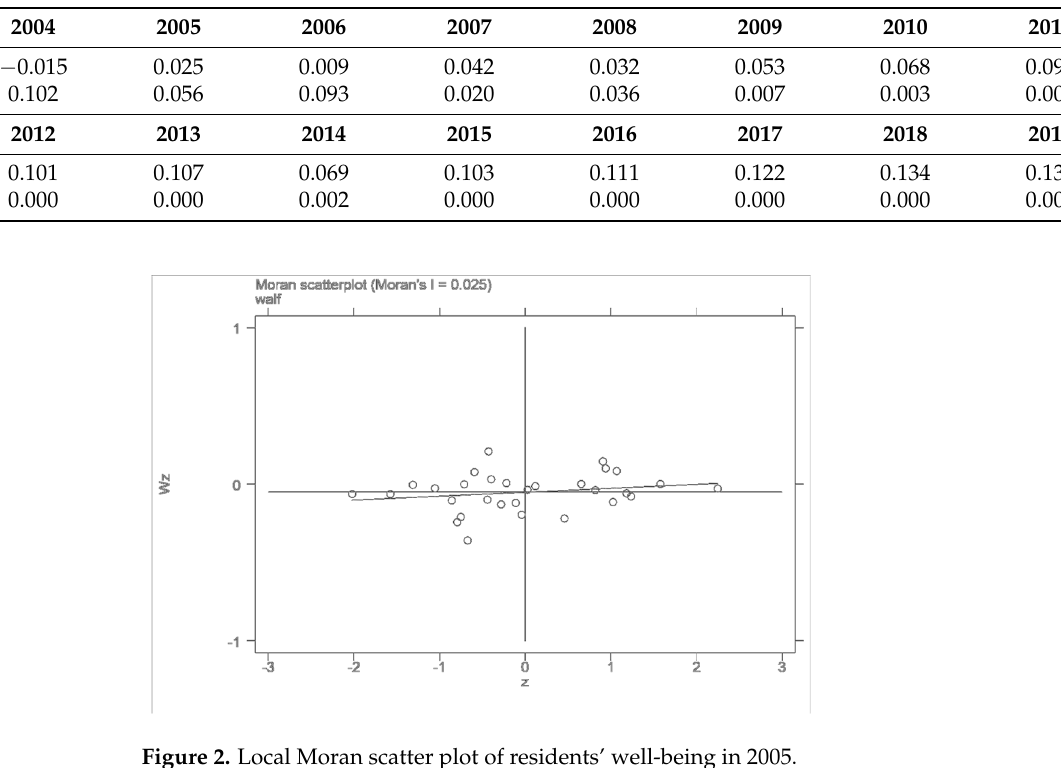
China, 2004–2019.